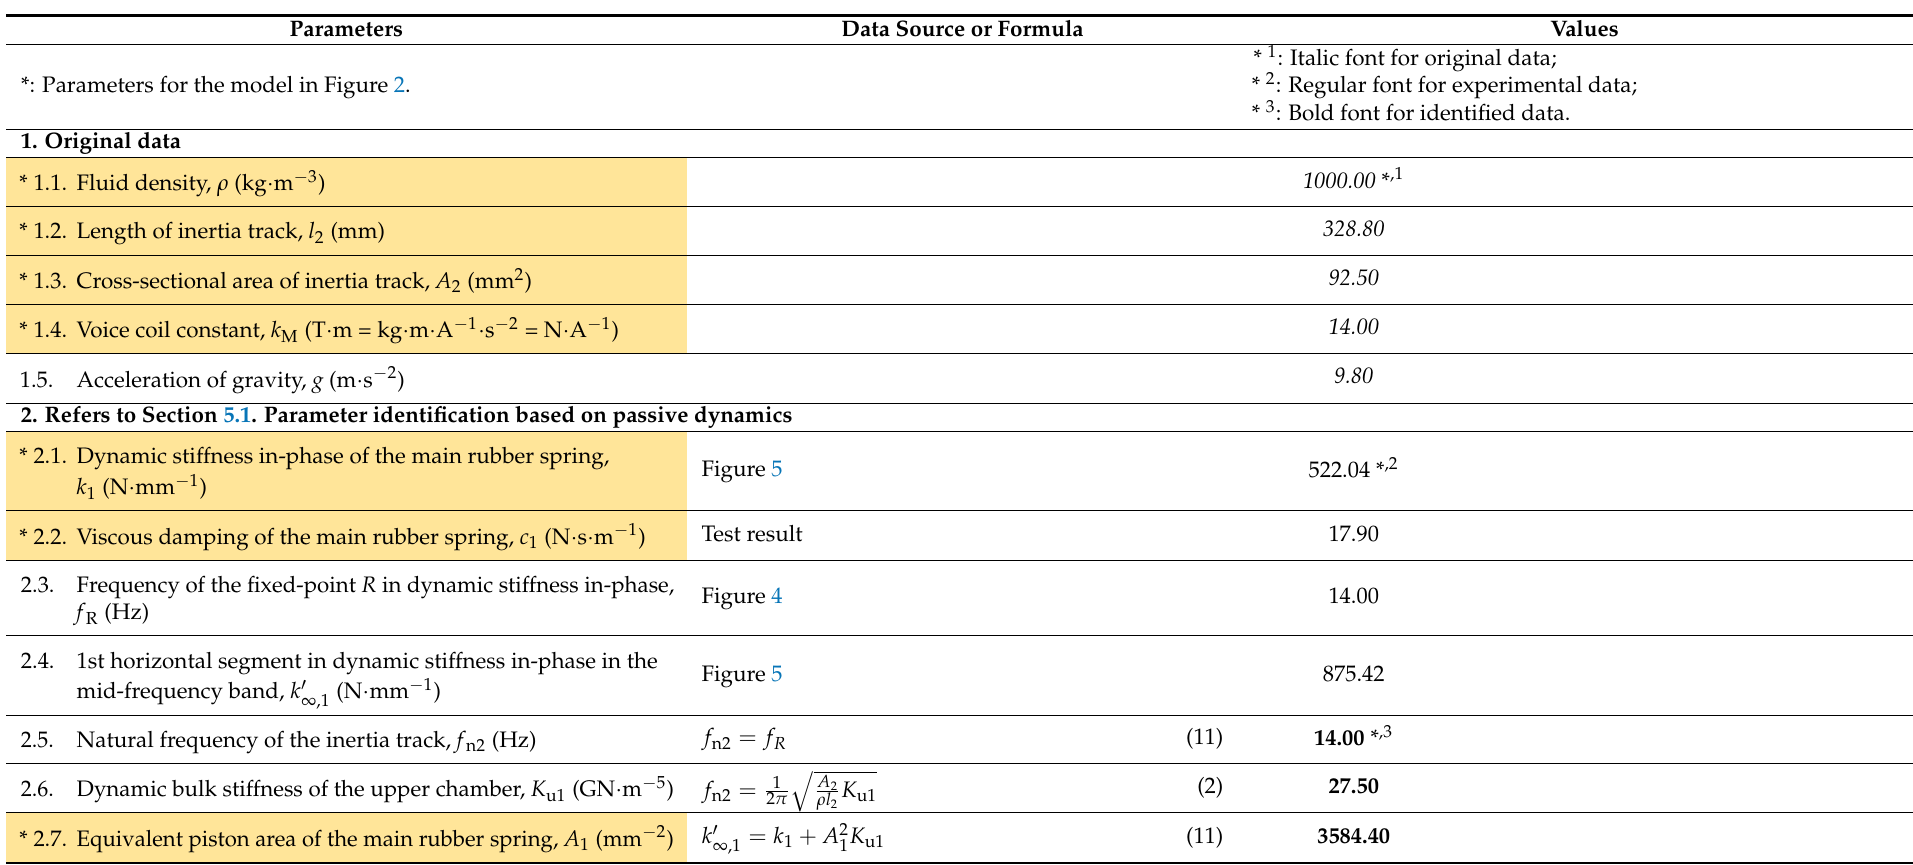
Table A1. Parameter identification procedure and obtained results for an AHM-IT-DM-OCA. Parameters Data Source or Formula